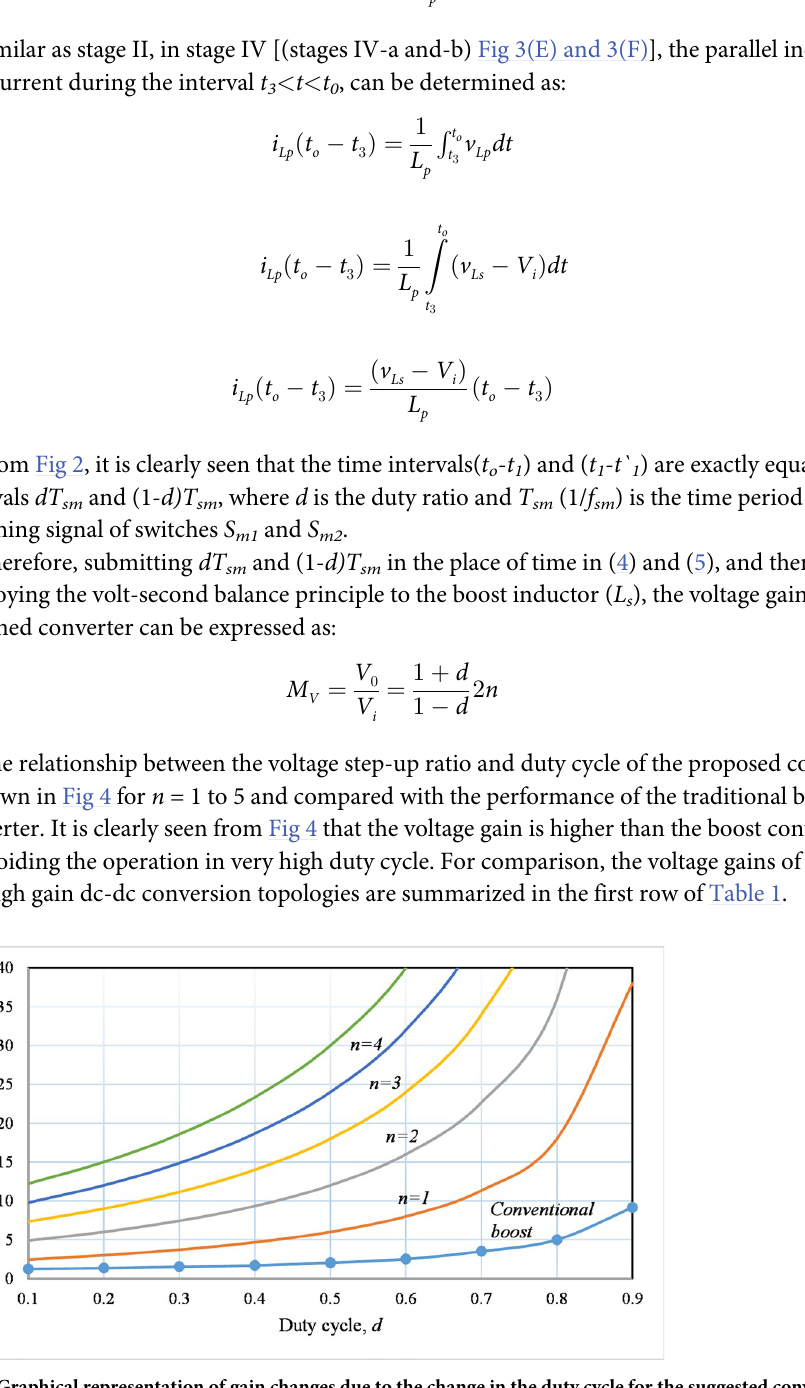
Fig 4. Graphical representation of gain changes due to the change in the duty cycle for the suggested converter for n = 1to 5 and the conventional boost dc-dc converter.